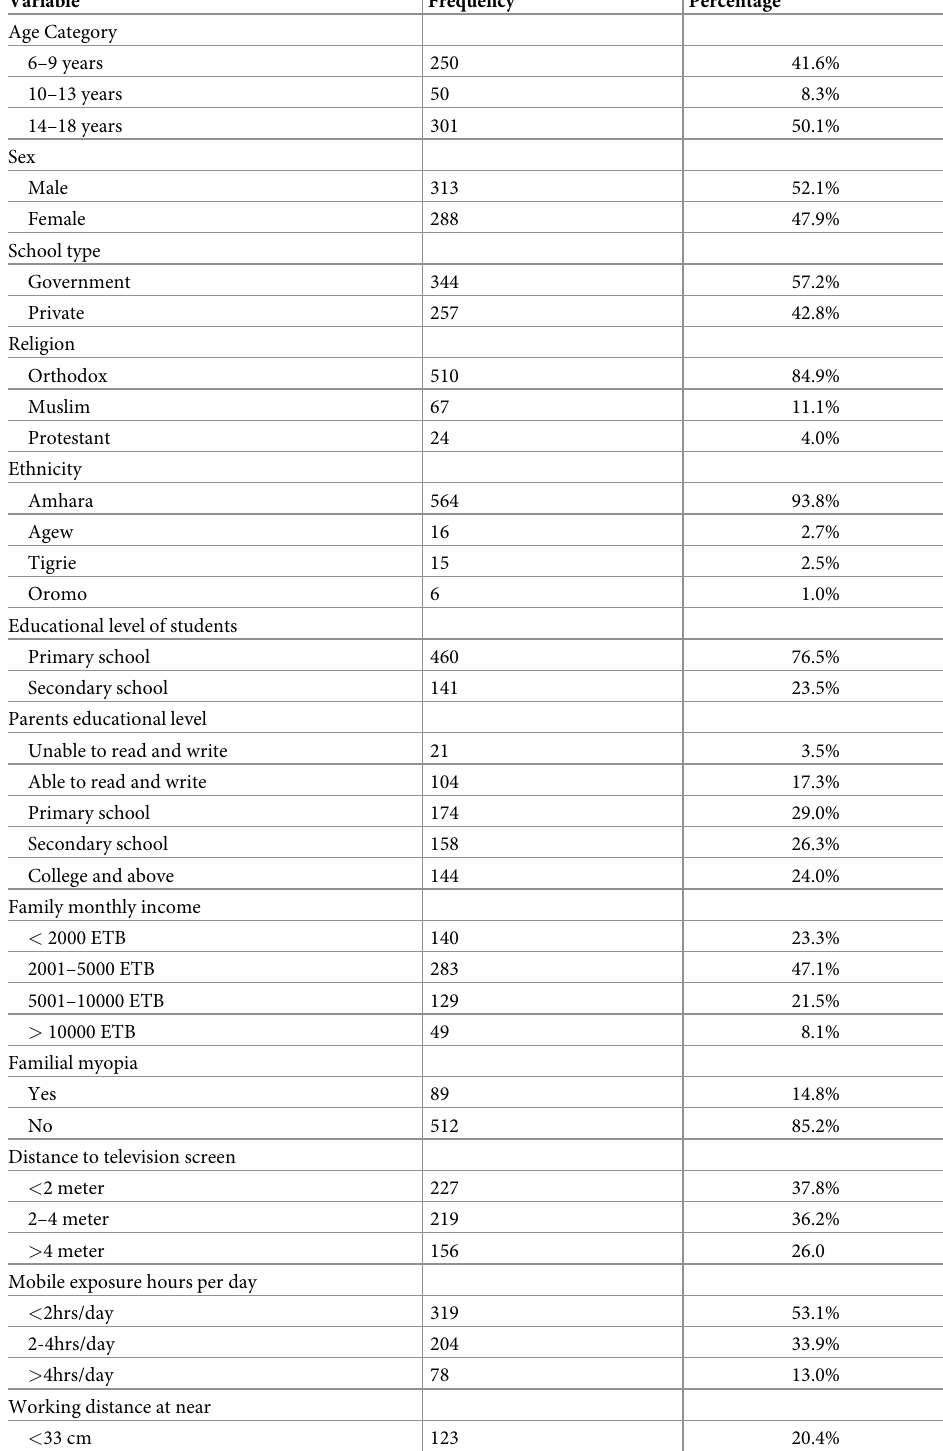
Table 1. Socio-demographic characteristics of the study participants among school children of Bahir Dar city, Northwest Ethiopia, 2019 (n =